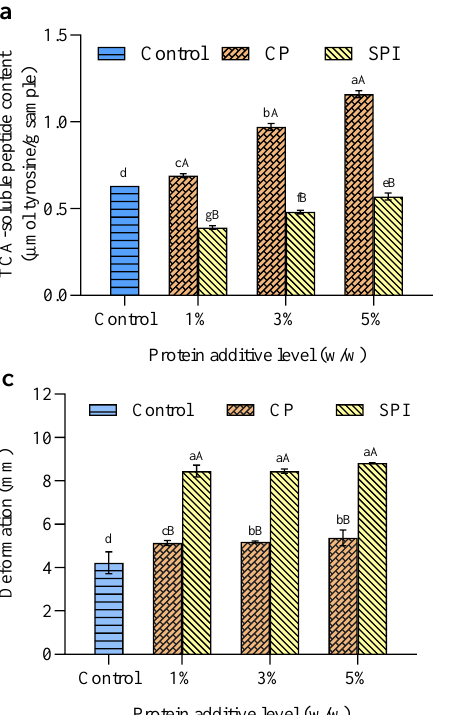
Figure 1. Changes in storage modulus (G′), loss modulus (G″), and loss tangent (tan δ) of mackerel surimi gels at various concentrations of cricket powder (CP) ( a , c , e ) and soy protein isolate (SPI) ( b , d , f ) during the heating.